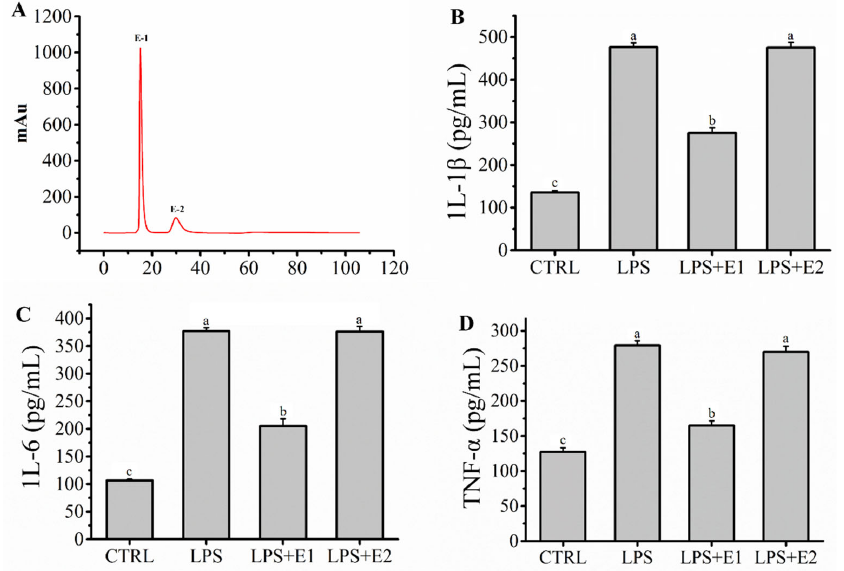
Figure 3. ( A ) HiTrap Capto DEAE ion exchange chromatography of peptides from GBP ‐ E; ( B – D ): Effects of GBP-E (1–2) pre-treatment (200 µ g/mL) on levels of IL-1 β , IL-6 and TNF- α on model of LPS-mediated RAW264.7 macrophages damage. Different letters (a, b and c) in the figure represent significant differences between groups ( p <